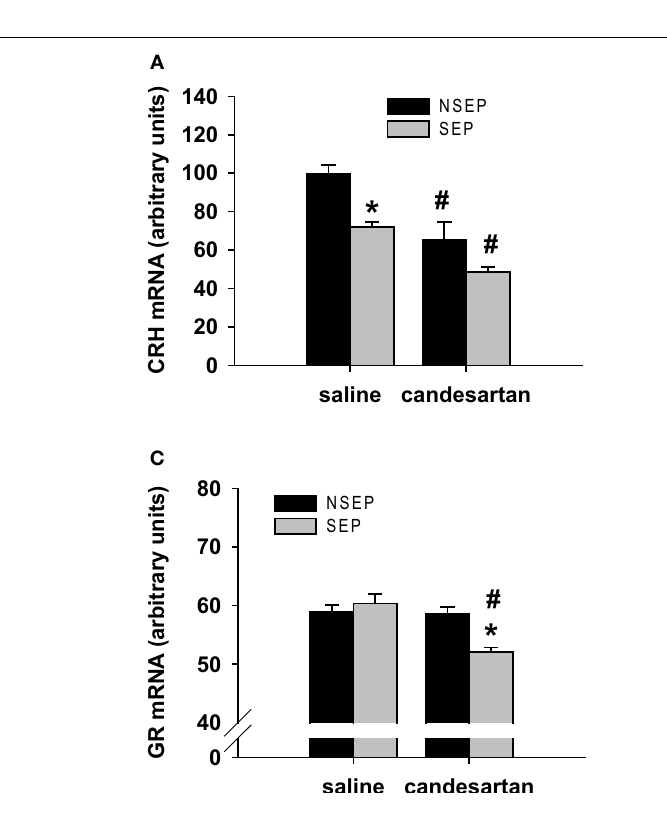
FIGURE 3 | Effects of candesartan treatment in non-separated (NSEP) and separated (SEP) mouse pups on CRH mRNA expression (A) in the PVN and GR mRNA expression (C) in the CA1 region of the hippocampus. CRH mRNA expression was signifi cantly decreased by maternal separation and candesartan treatment. The lowest expression of CRH was observed in candesartan-treated, separated mouse pups. GR expression was not